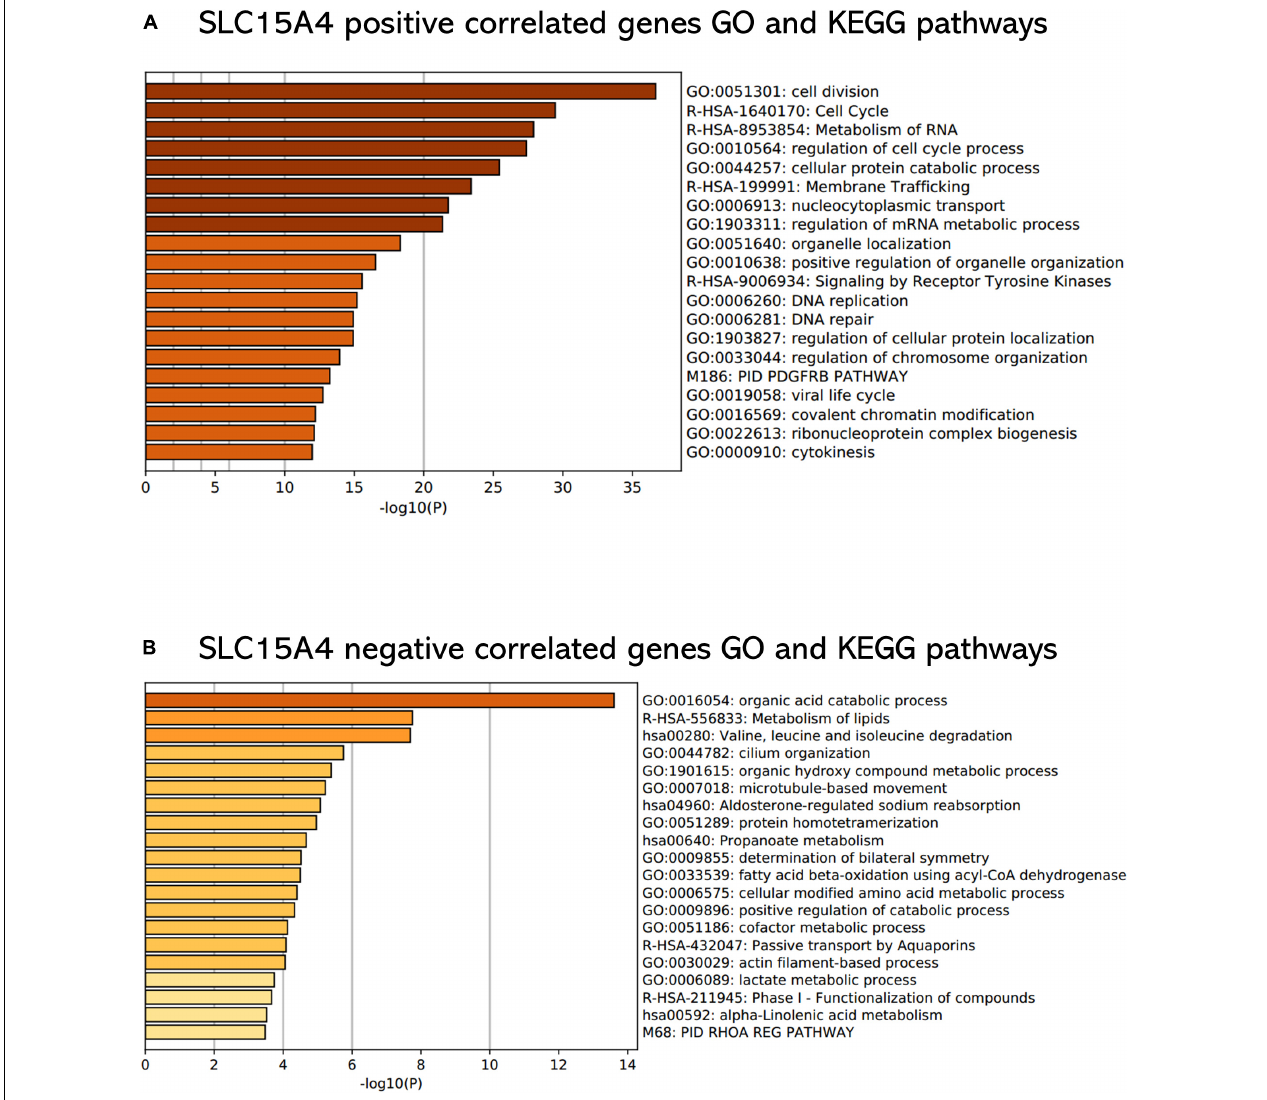
FIGURE 7 | Functional enrichment analysis of Gene Ontology terms and KEGG pathways. (A) Enrichment analysis of positively correlated genes with Pearson correlation > 0.3. (B) Enrichment analysis of negatively correlated genes with Pearson correlation < –0.2. The P value was calculated and sorted with -log10(P). Dark red indicates the smallest P